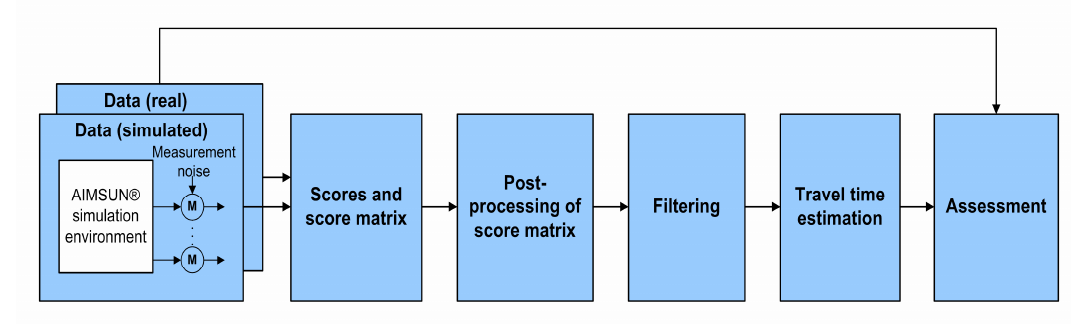
Figure 1. Overall procedure of the